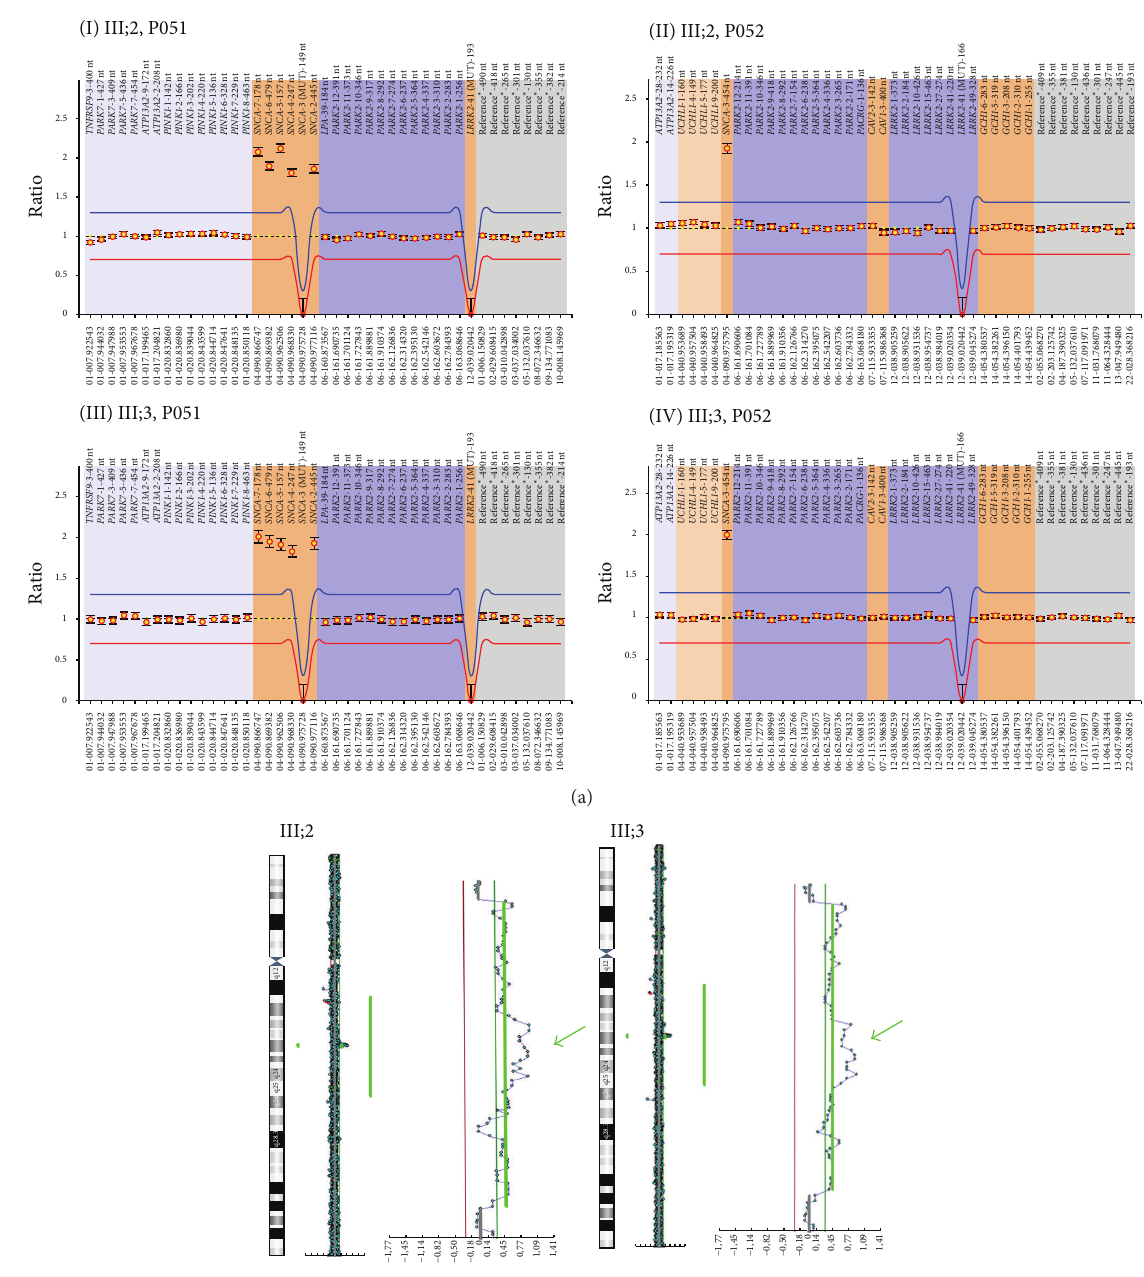
Figure2: SNCA dosageusingCGH-ArrayandMLPA.(a)MLPAanalysis.Intheseimages,normalizedpeakareasrelativetoprobesconsidered inMLPAkitP051(IandIII,resp.,III;2andIII;3)andP052(IIandIV,resp.,III;2andIII;3)areshown.(IandIII)Theprobesrelatedto TNFRSF9 (one probe), PARK7 (twelve probes), and ATP13A2 (two probes) genes are shown in light blue, SNCA (five probes) and two mutation specific probes for p.A30P in SNCA and p.G2019S in LRRK2 genes in brown, LPA (one probe) and PARK2 (twelve probes) genes in dark blue, and the reference probes (eight) in gray. (II and IV) The probes related to genes ATP13A2 (two probes) and UCHL1 (four probes) are shown in light blue, PARK2 (twelveprobes),PACRG(oneprobe), LRRK2 (eightprobes),andonemutationspecificprobeforp.G2019Sin LRRK2 indarkblue,